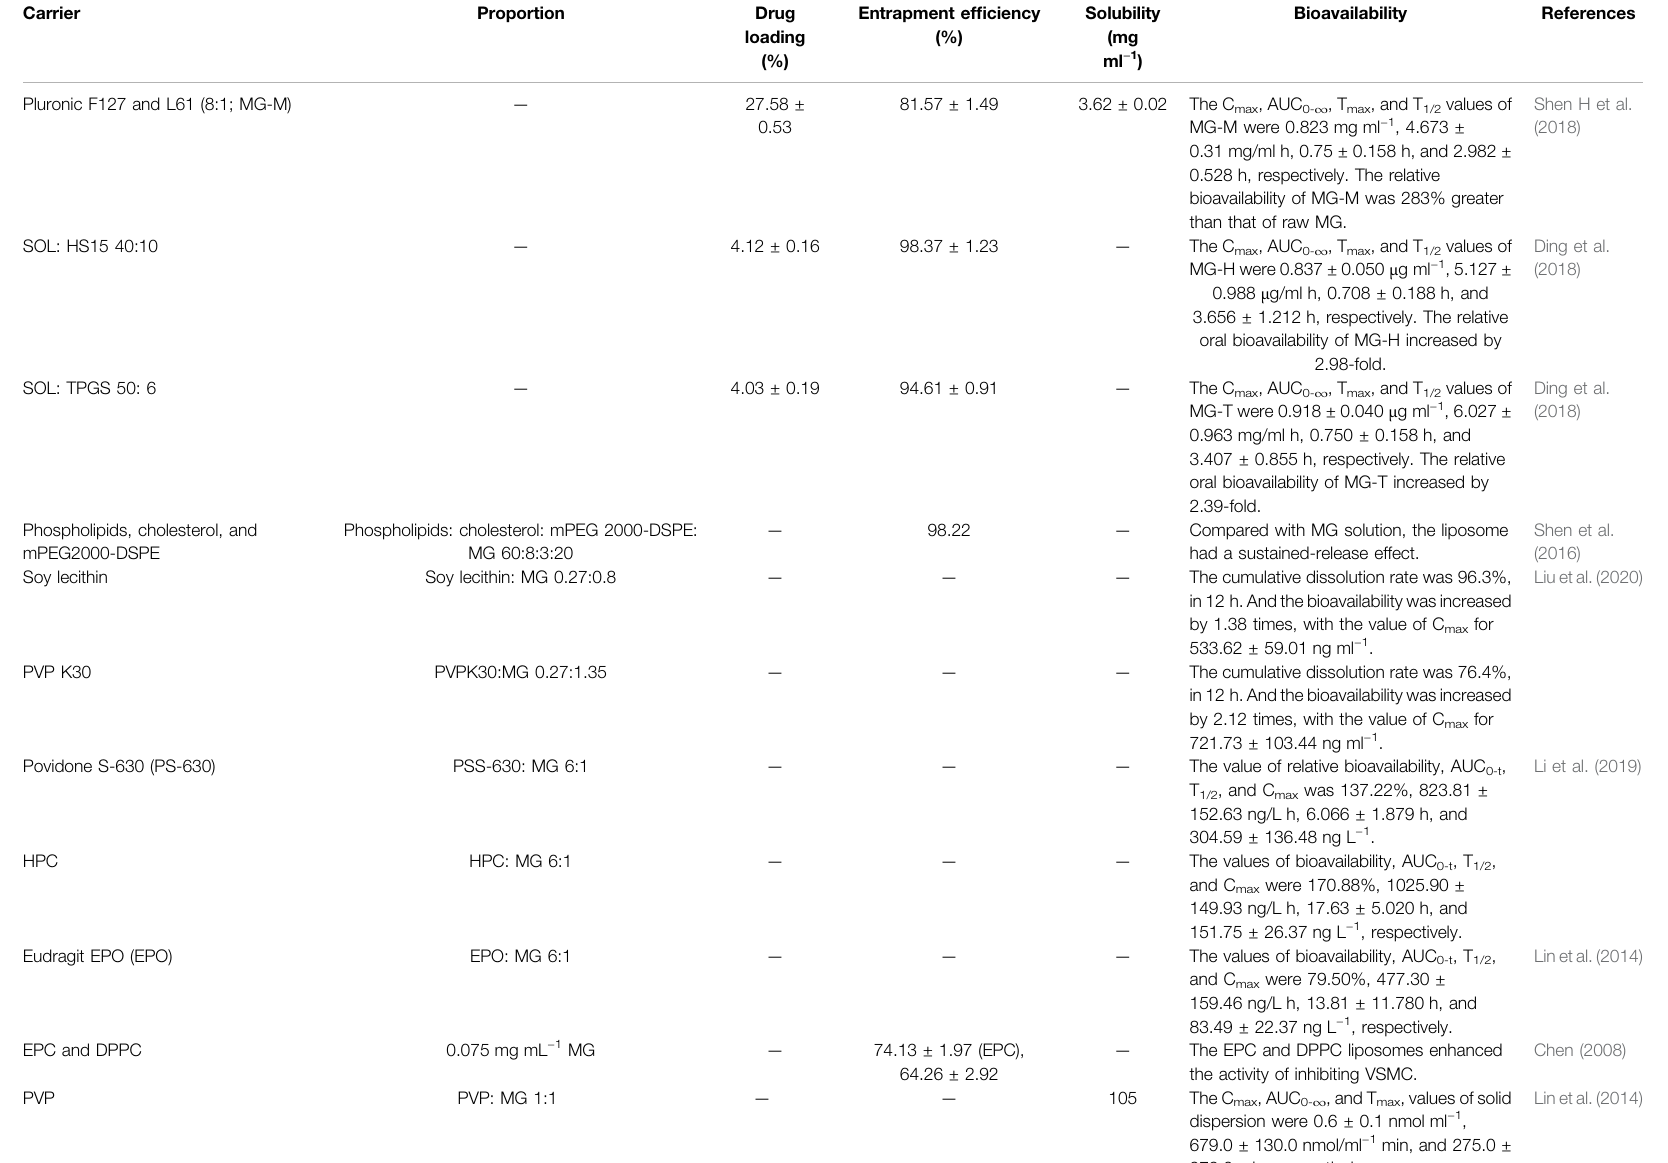
TABLE 3 | Formulations of